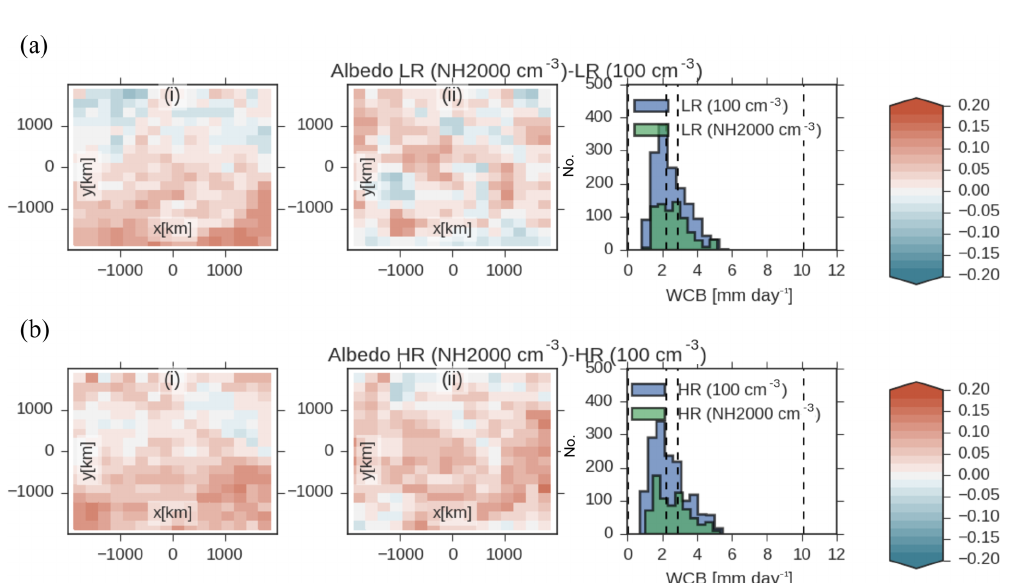
Figure 12. As in Fig. 8, but showing differences in